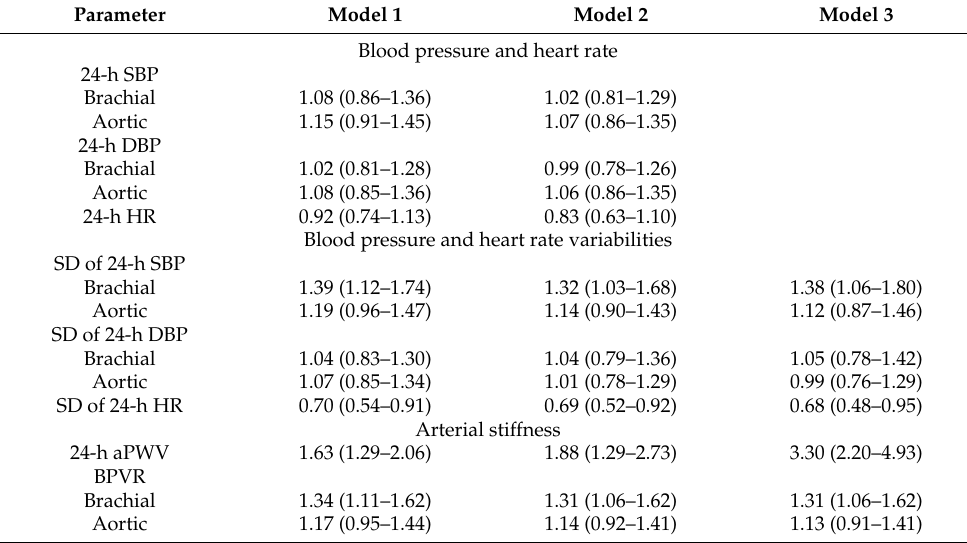
Table 2. Hazard ratios for 1 SD change in 24 h blood pressures, 24 h heart rate, blood pressure and heart rate variabilities, aortic pulse wave velocity (aPWV), and blood pressure variability ratio (BPVR) in relation to 1-year mortality.